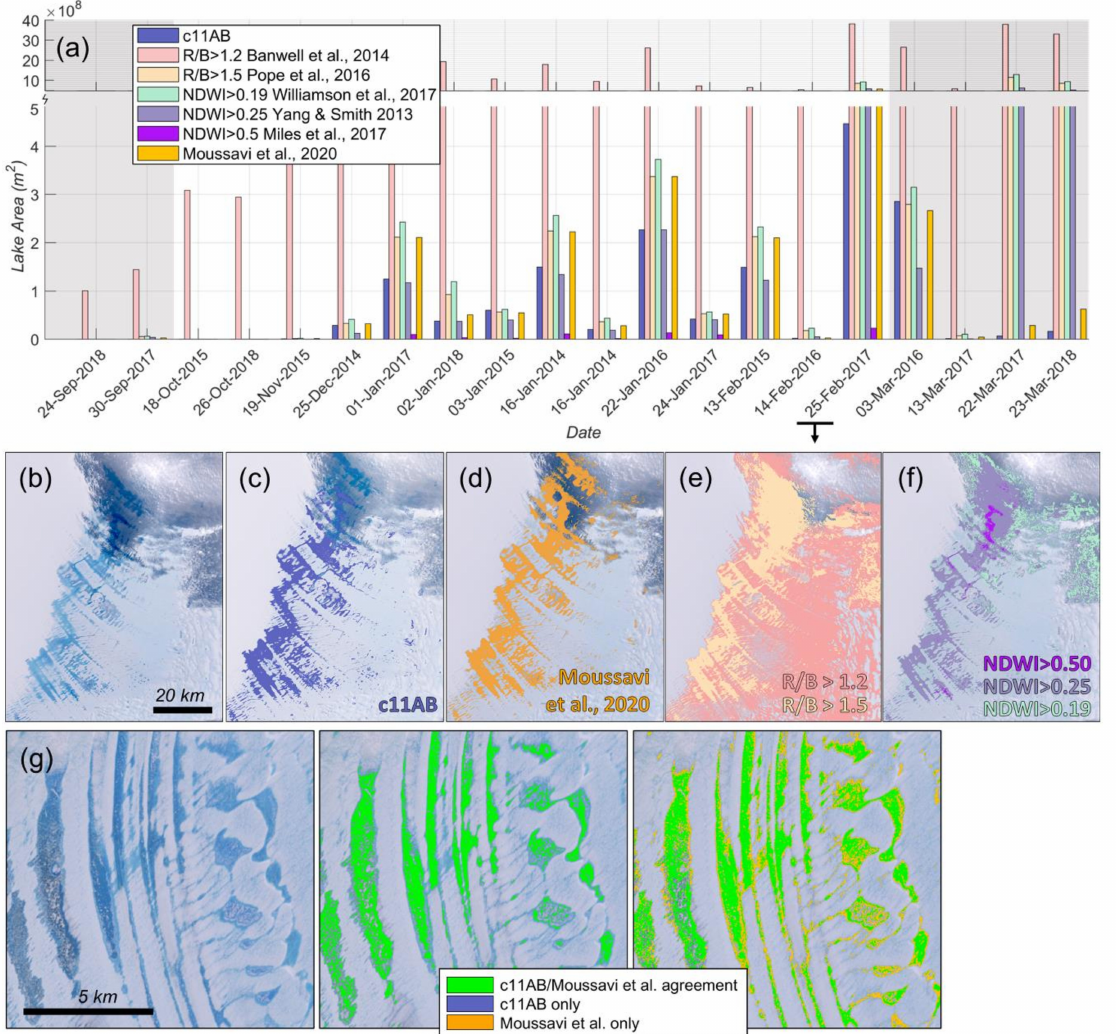
Figure 8. ( a ) Comparison of our supervised classifier with published band thresholding methods developed for other polar regions, applied to Roi Baudouin Ice Shelf application scenes following automated cloud removal. Grey shading indicates scenes with sun elevation below 20 ◦ . Note the upper scale is compressed to show the exceedingly high (misclassified) lake areas for some low-sun-elevation scenes. ( b ) The true-color image shows a subset of scene LC08_L1GT_154109_20170225 with enhanced contrast to highlight lakes partially visible beneath cloud shadows. Lakes identified by our c11AB classifier ( c ) are compared to previously published lake identification methods based to the ratio of red to blue reflectance: ( d ) multi-band thresholding by Moussavi et al. [85]; ( e ) Red / blue (‘R / B’) thresholds from Banwell et al. [54] for the Larsen B Ice Shelf, Antarctica, and Pope et al. [58] for West Greenland; ( f ) Normalized Di ff erence Water Index (‘NDWI’) thresholds from Williamson et al. [63] for West Greenland, Yang & Smith [52] for southwestern Greenland, and Miles et al. [59] for West Greenland. ( g ) Lake results from c11AB are compared to multi-band thresholding for scene